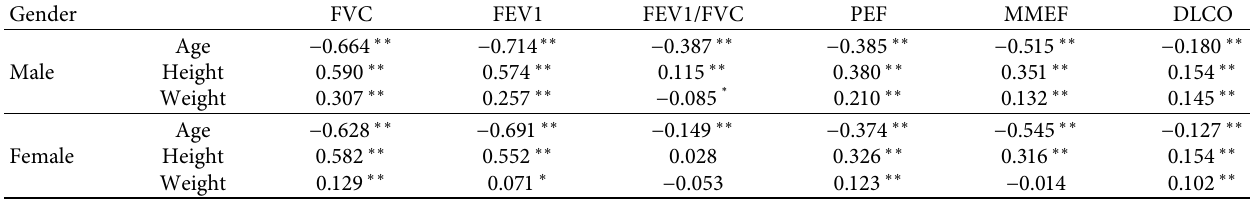
Table 3: Pearson’s correlation analysis of lung function parameters and age, height, and weight, stratified by sex.